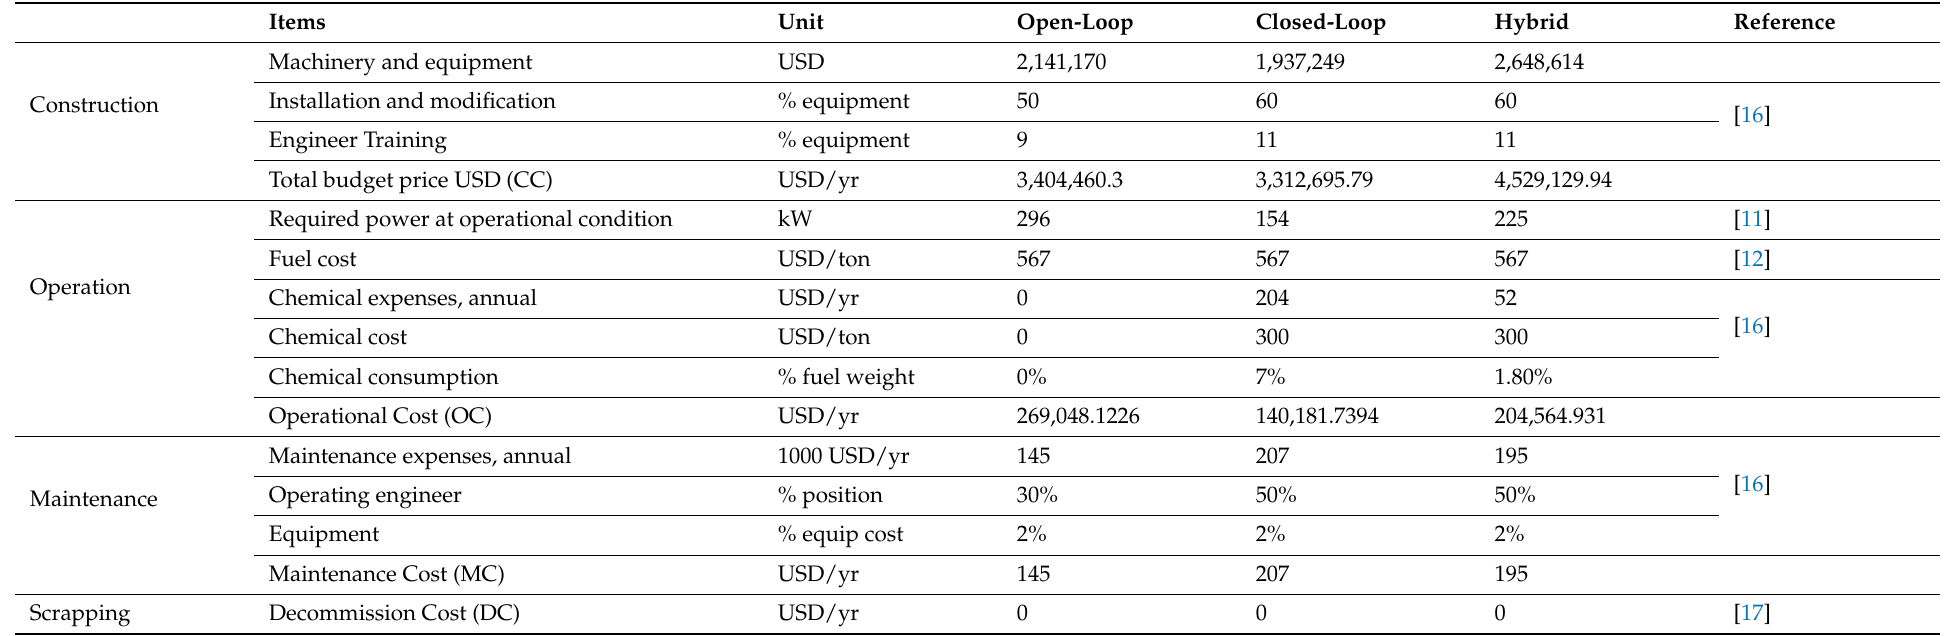
Table 6. Summary of LCCA estimates.